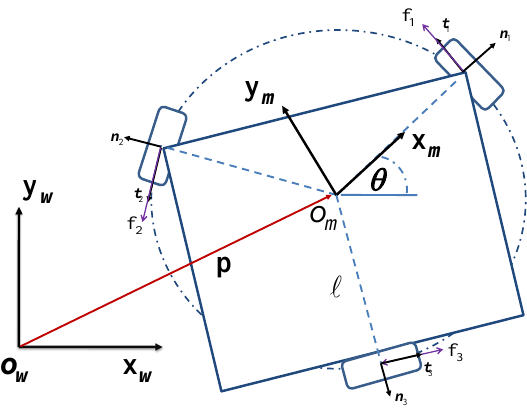
Figure 1. Three dimensional plot of mobile robot with S θ = sin ( θ ) and C θ = cos ( θ ) .